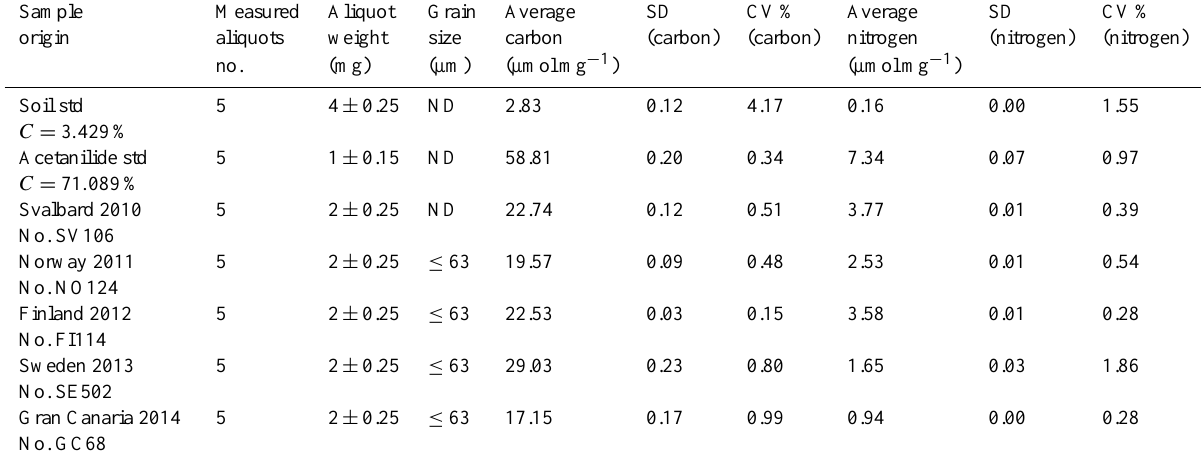
Table 2. Results from replicate carbon and nitrogen measurements of ground sediment trap material used to test its homogeneity. Powdered samples originating from different pelagic mesocosm experiments were tested and compared with commercially available standards com- monly used for calibration of elemental analysers (soil standard (std), acetanilide standard (std)). Homogeneity is expressed by the coefficient of variation in percent (CV%). Also presented are the number of measured aliquots, the amount of material analysed, average carbon content, calculated standard deviation (SD), and grain size derived from scanning electron microscopy. ND: grain size not